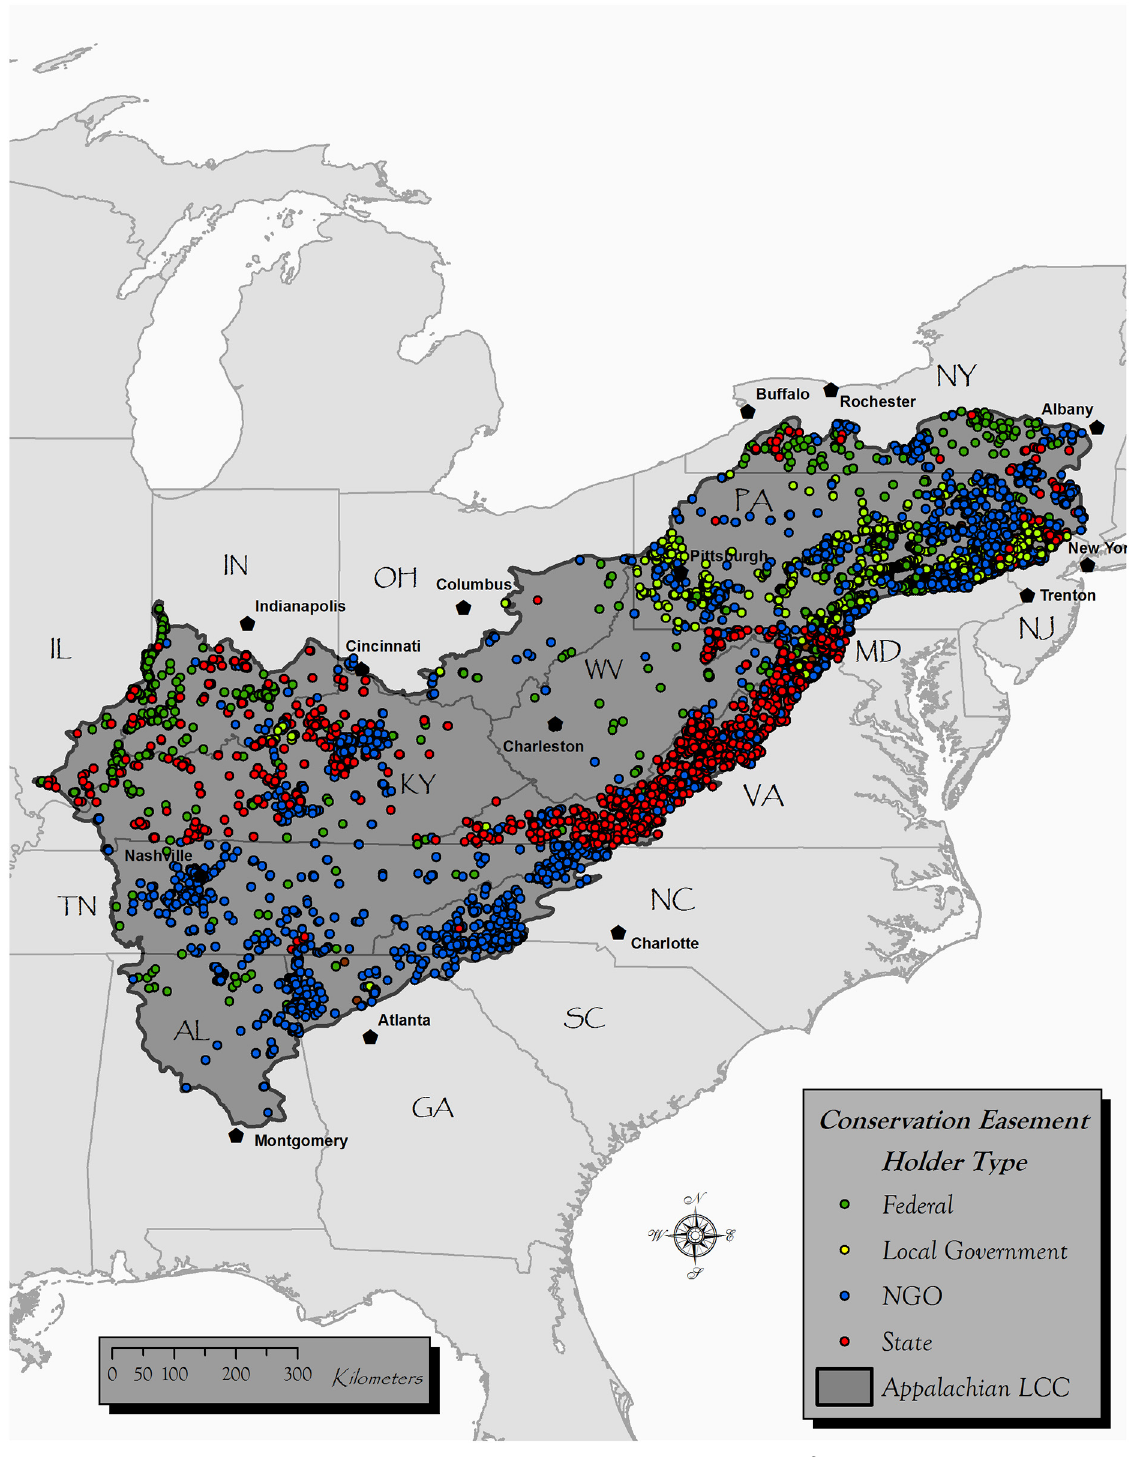
Fig 1. Spatial distribution of conservation easements within the study area (589,000 km 2 ). Easement locations are categorized by 4 holder types.